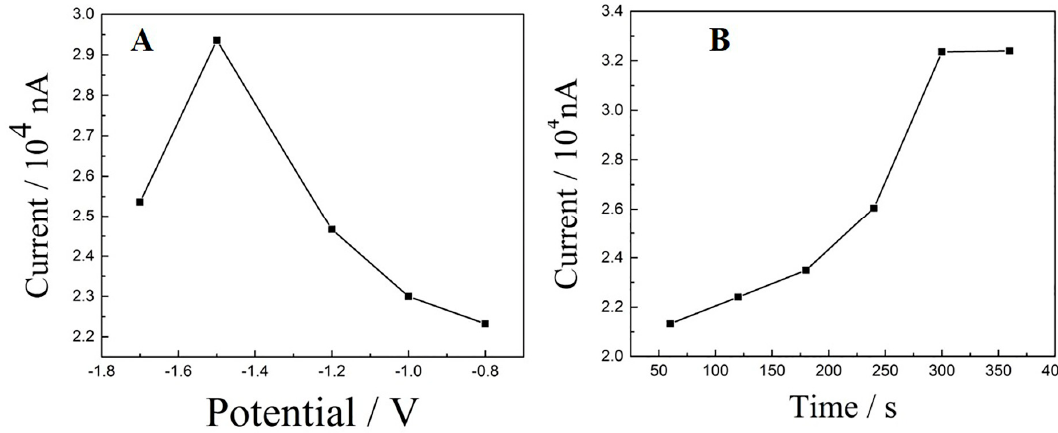
Figure 3. Optimization of reduction potential ( A ) and reduction time ( B ) for electrochemical reduction of Cu 2 O-GO nanocomposites.